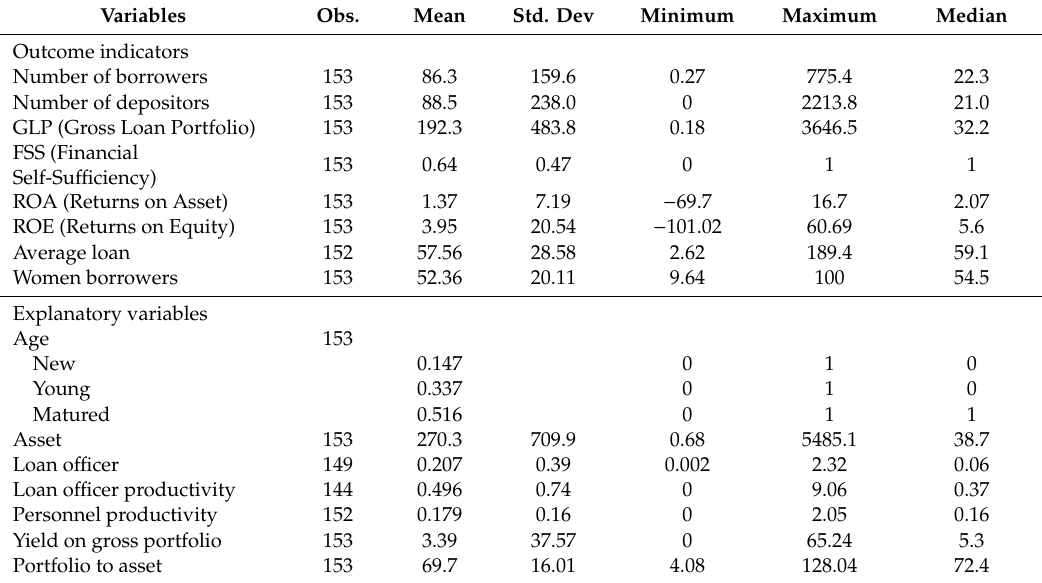
Table 1. Descriptive statistics.